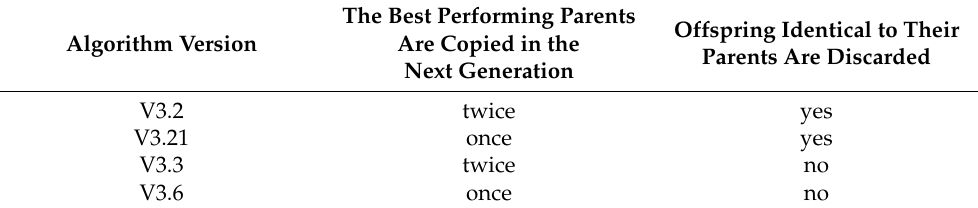
Table 1. Differences between versions of genetic algorithm implementations.